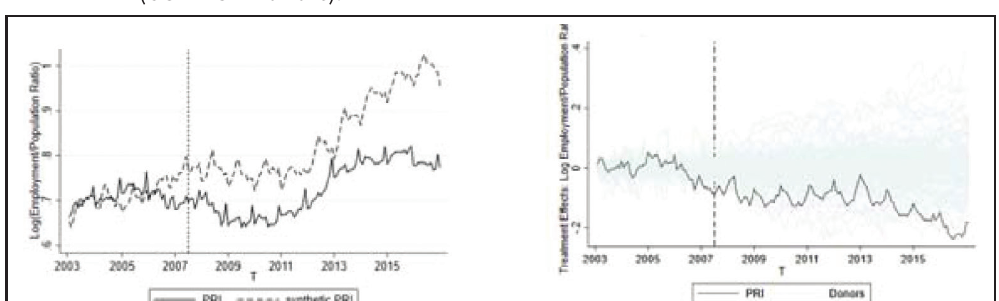
Treatment Effects and Placebo Test: Accommodation and Food Industry (USA MSA Donors).